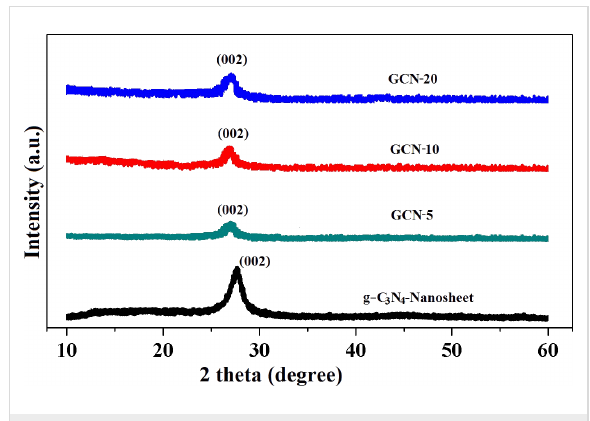
Figure 2: Powder X-ray diffraction patterns of the synthesized rGO- supported C 3 N 4 (GCN) hybrid materials.